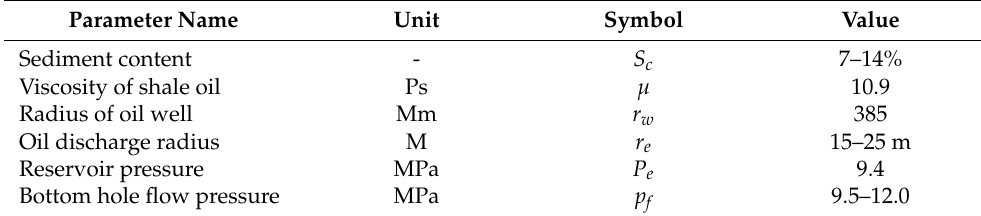
Table 7. Calculation parameters of the pyrolysis